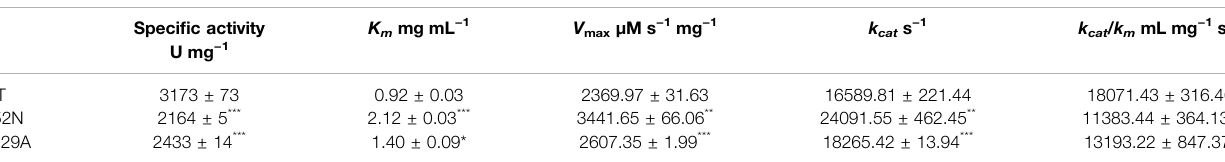
TABLE 3 | Kinetic analysis of wild-type pepsin and its